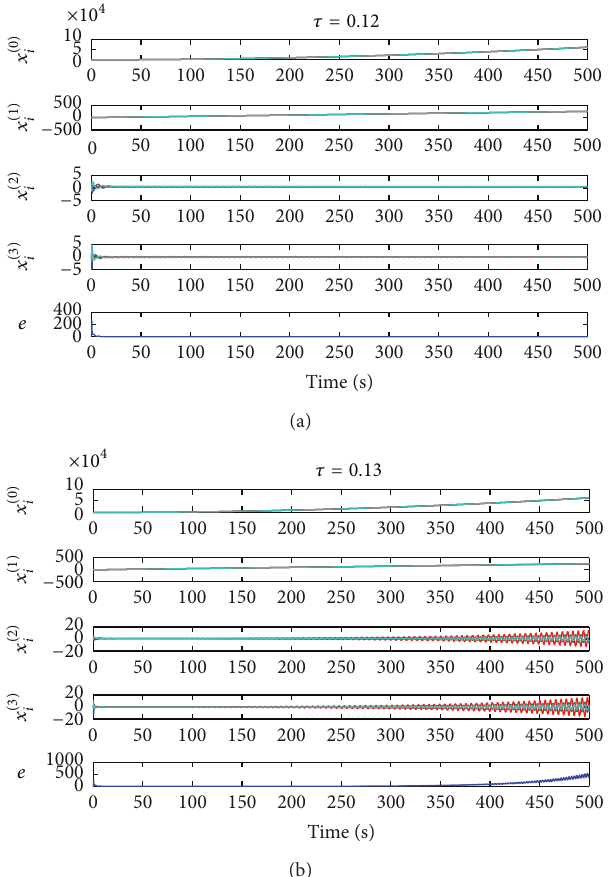
Figure 2: Evolutions of the fourth-order consensus with communi- cation time-delays on graph 𝐺 given in Figure 1: (a) 𝜏 = 0.12 and (b) 𝜏 = 0.13 .